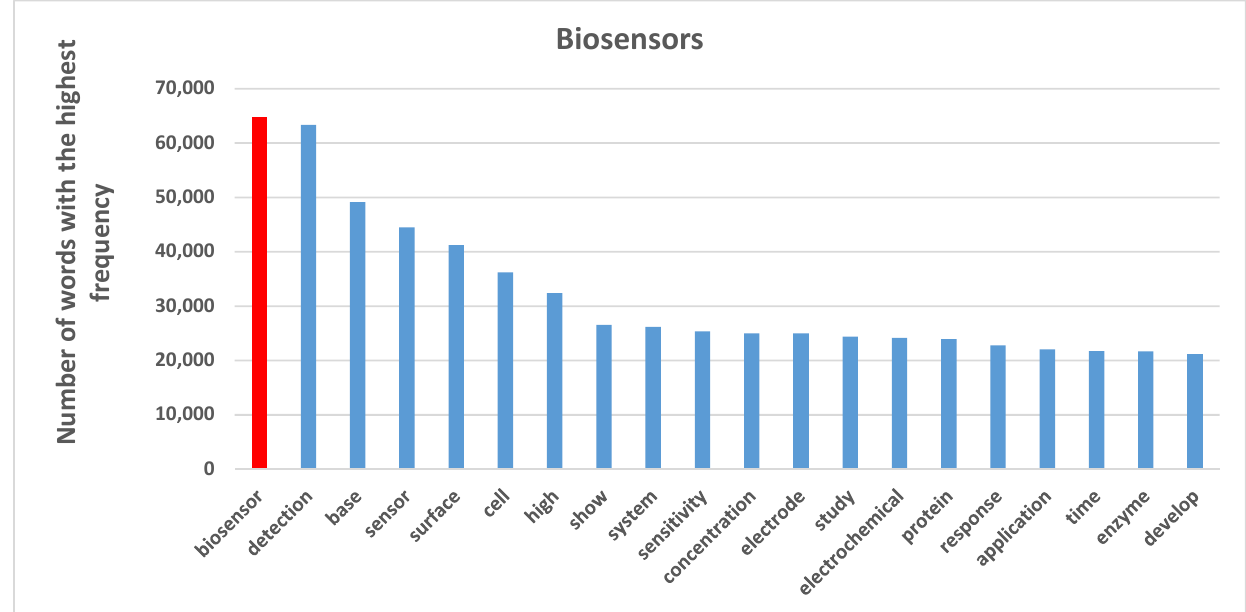
Figure 8. The highest frequent words in documents of biosensors.